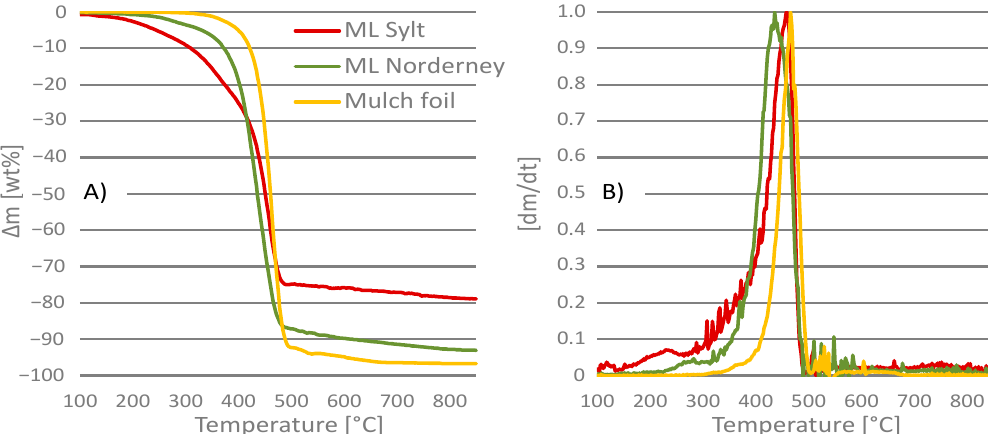
Figure 7. ( A ) shows the TGA mean value of gasification. ( B ) shows the standardised DTG signal. (ML Sylt n = 4, ML Norderney n = 4, Mulch foil n = 3).